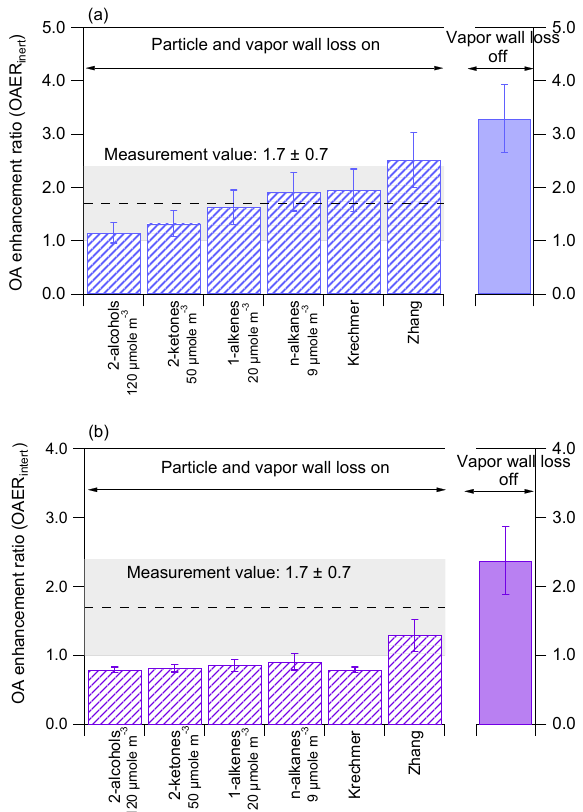
Figure 4. OAER inert enhancement ratios in the simulations, as cal- culated from Eq. (7), using saturation concentrations ( C w / M w γ w ) of 120, 50, 20, and 9µmolem − 3 as suggested by Matsunaga and Ziemann (2010) and for varying C w / M w γ w as suggested by Krech- mer et al. (2016) and Zhang et al. (2015). Two sets of reaction rates have been applied: (a) upper-bound chemistry ( k OH set for aromat- ics with four-volatility-bin drop per reaction) and (b) lower-bound chemistry ( k OH set for alkanes with two-volatility-bin drop per re- action). The mass accommodation coefficient is set to 1 × 10 − 5 in all simulations. The striped bars represent the simulations with par- ticle and vapor wall loss on and the solid bars represent the sim- ulations with vapor wall loss off. The dashed line and grey area represent the measurement value and its standard deviation from Hennigan et al.